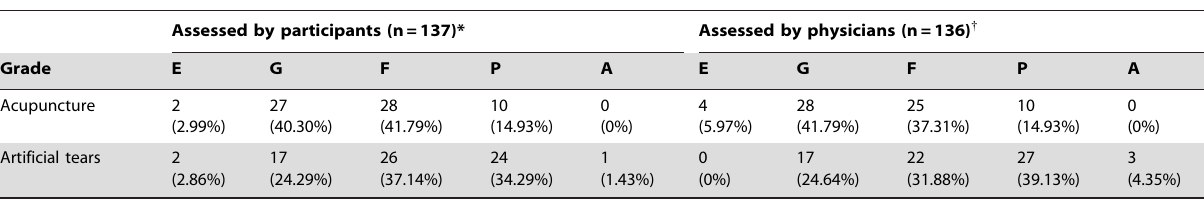
Table 3. General improvements of dry eye-related